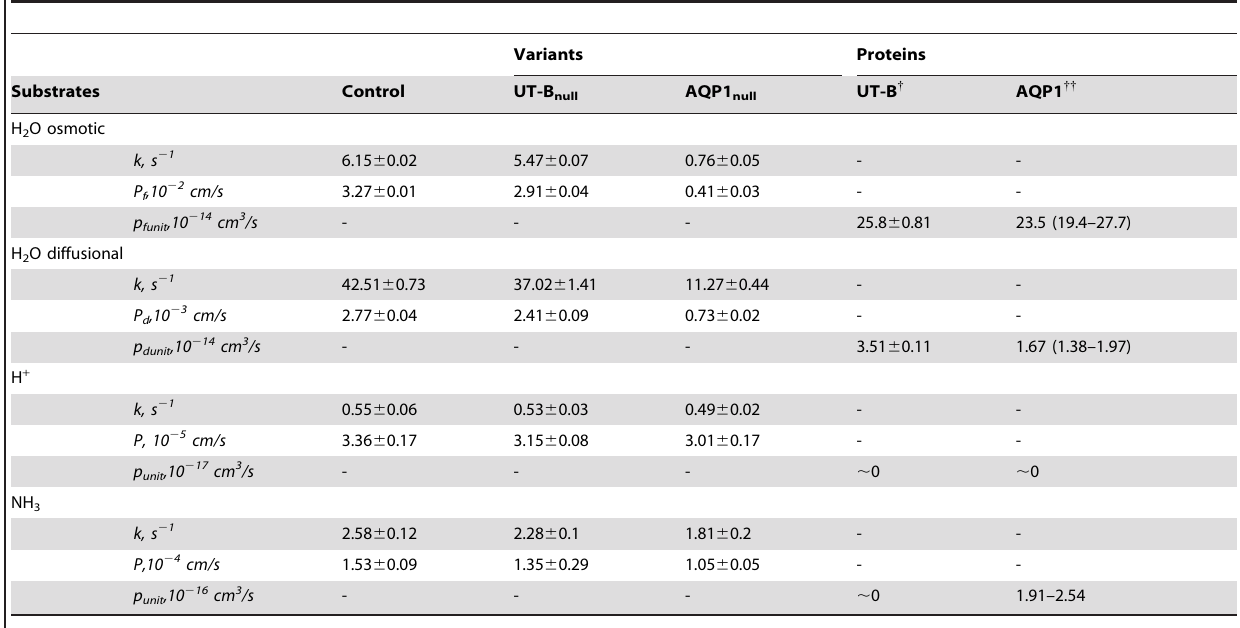
Table 2. UT-B and AQP1 unit permeabilities deduced from rate constants and permeabilities to water (pf and pd), to proton and to ammonia of human RBC variants.